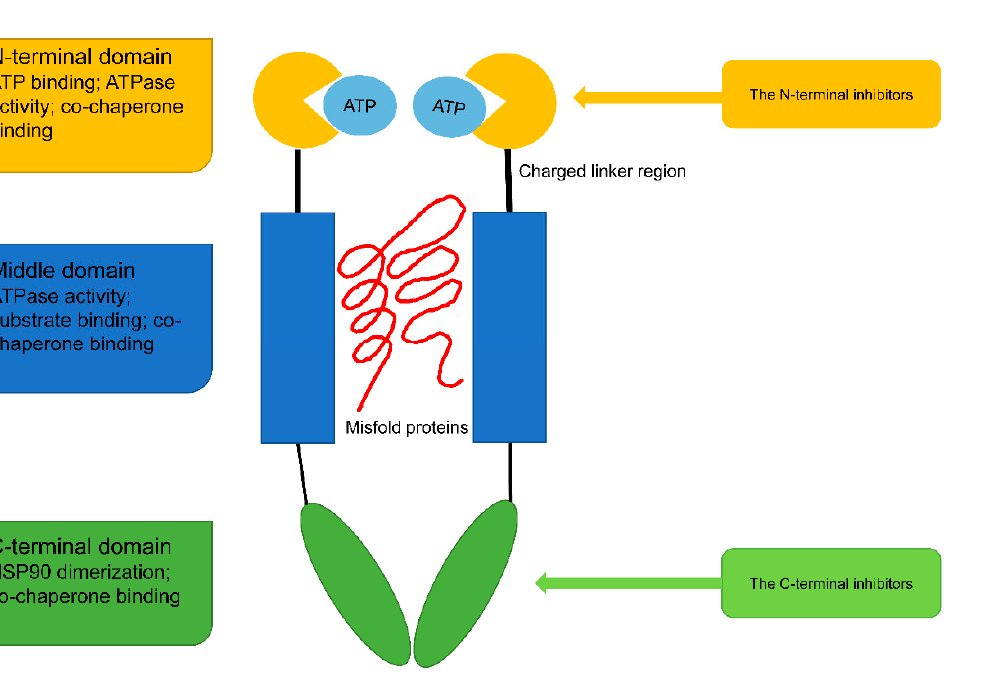
Figure 1. Basic structure of HSP90. The N-terminal domain contains ATP binding site with a special domain Bergerat fold; The charged linker region is a flexible linker between the N-terminal and middle domains; The middle domain is the binding site of client protein; The C-terminal domain is responsible for HSP90 dimerization; The N-terminal, middle domain and C-terminal domain all have the binding site of